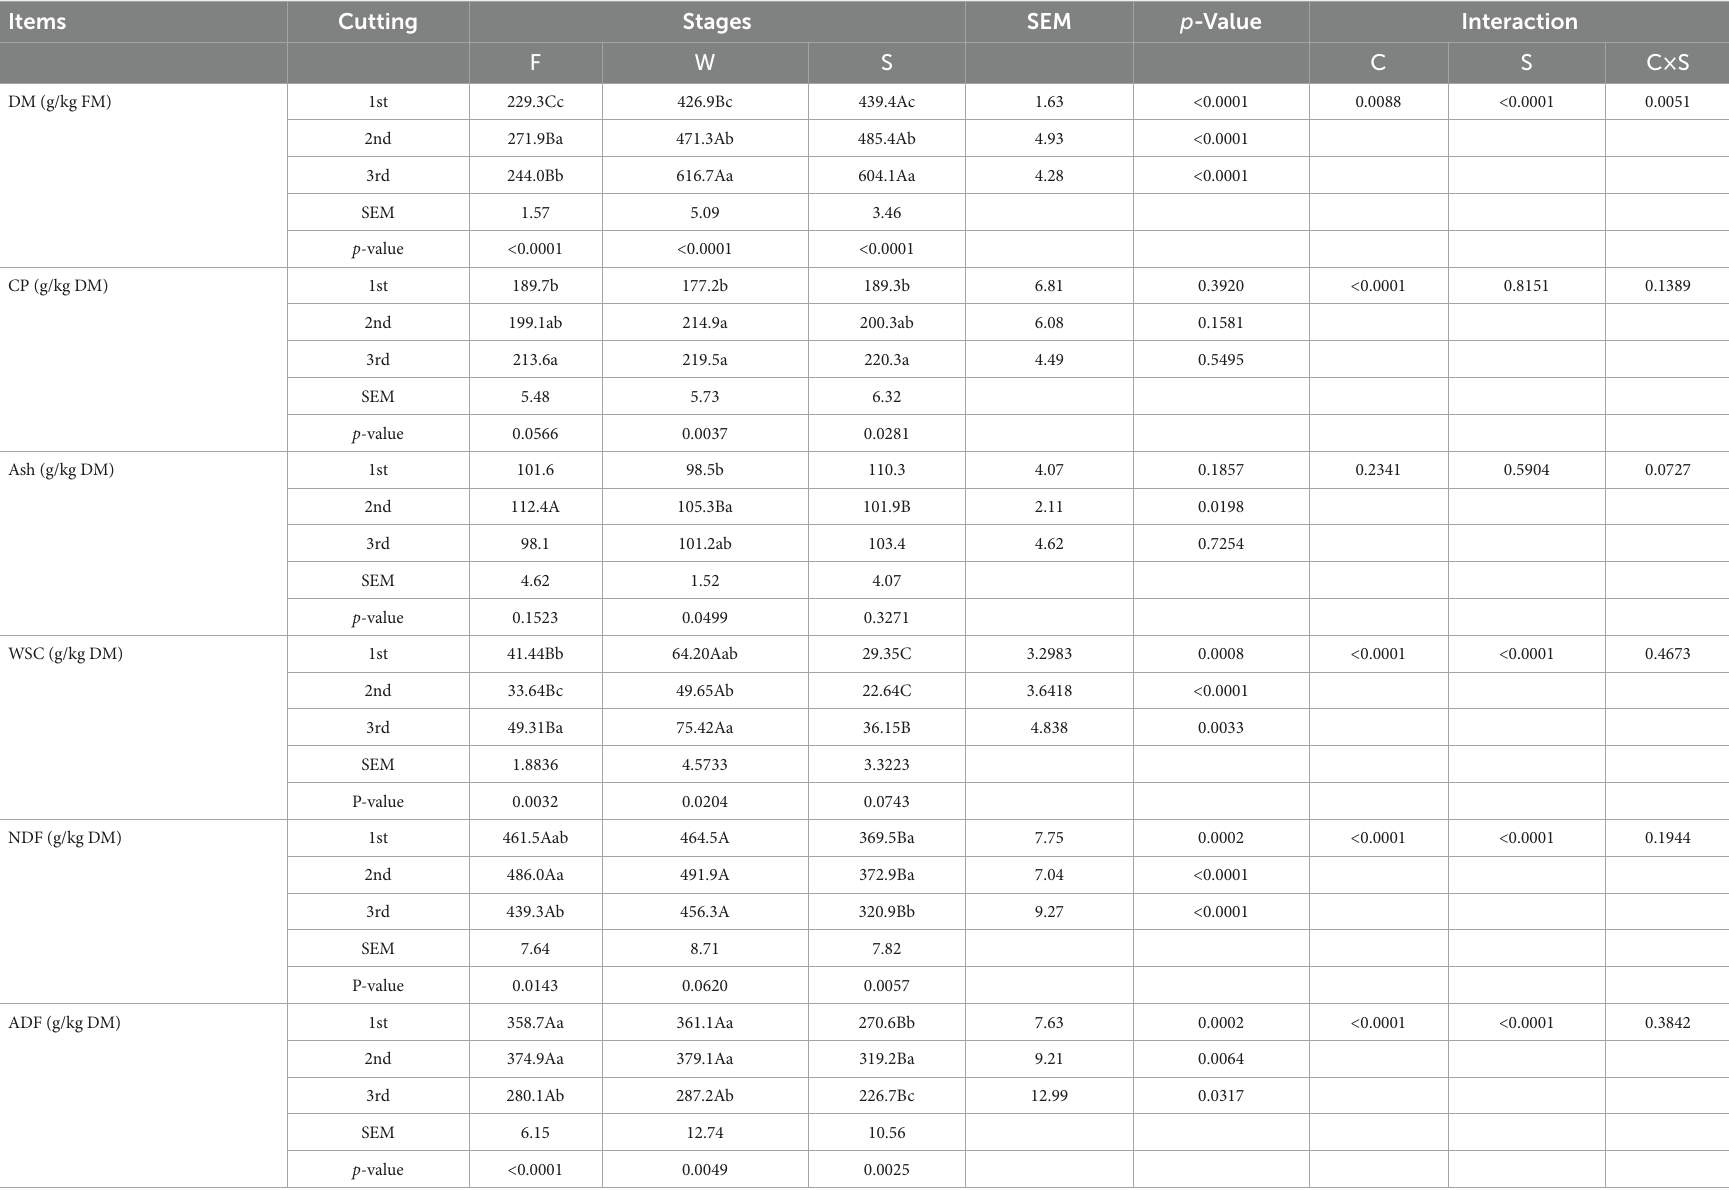
TABLE 2 Characteristics of chemical and microbial counts of fresh, wilted, and ensiled alfalfa at three cuttings. Items